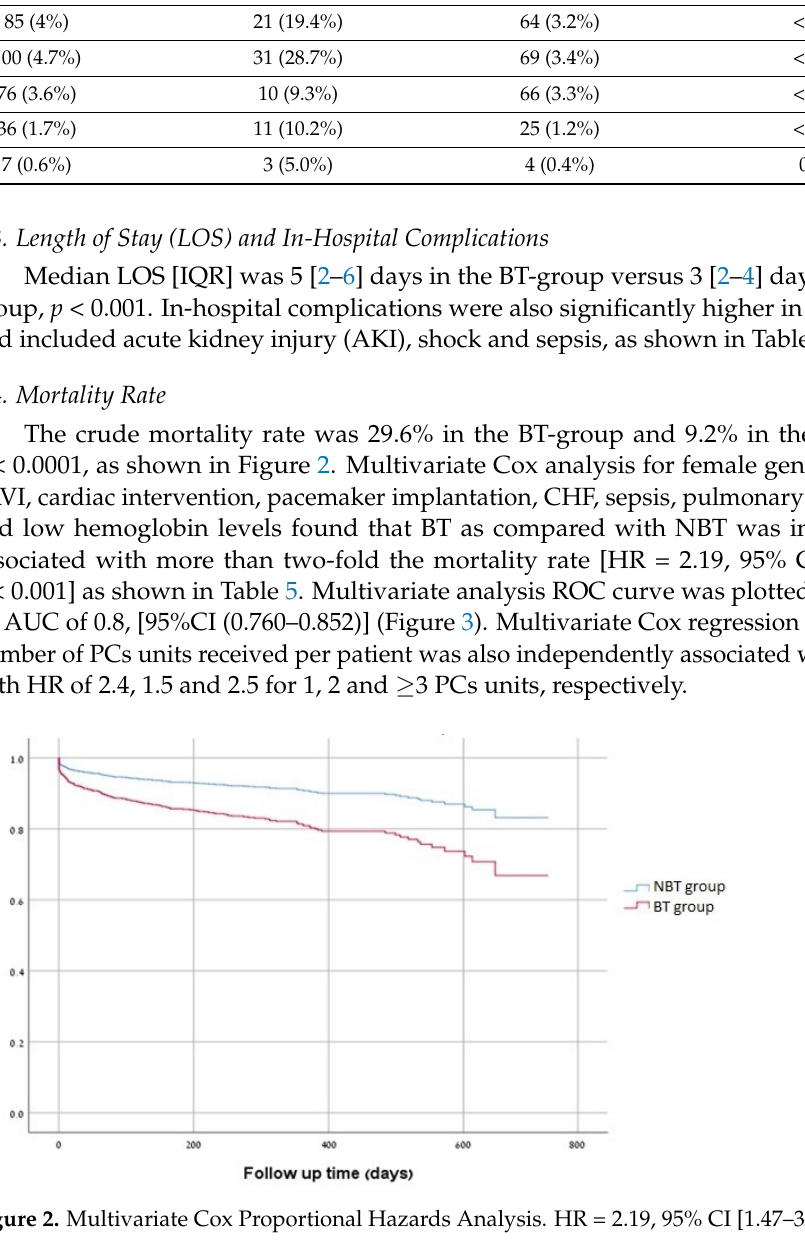
Table 4. Blood transfusion rate according to in-hospital complications.